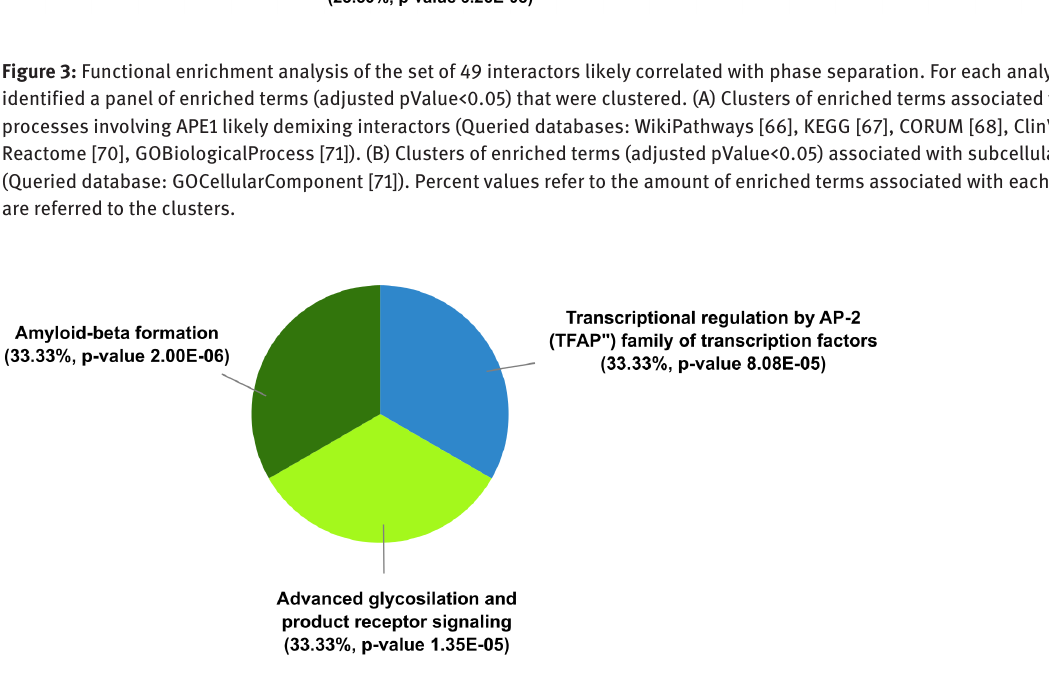
Figure 4: Functional enrichment analysis of the extended set of PhaSePro characterized proteins (including APE1). Enriched biological processes (adjusted pValue<0.05) interestingly suggest a role in amyloid formation, regulation of transcription and AGE receptor signaling (Queried databases: WikiPathways, KEGG, CORUM, ClinVar, Reactome, GOBiologicalProcess. Minimum number of genes per cluster set to